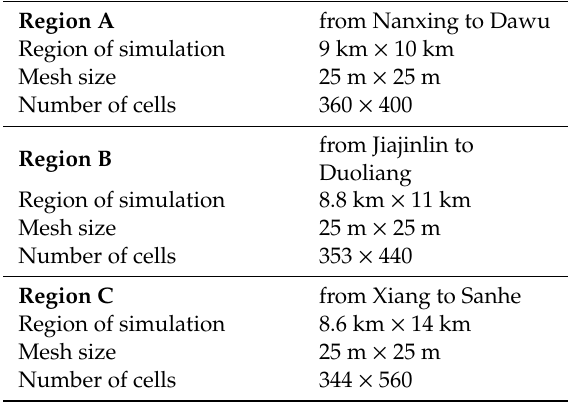
Table 3. Mesh specifications for near-field